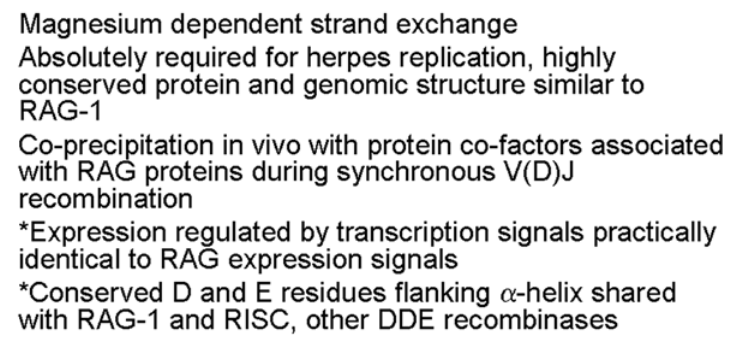
Figure 7. Summary of functional correlates between RAG-1 and herpes DBP (asterix indicates observations novel to this work, other observations presented previously). These functional correlates are consistent with a homologous descent of both proteins from a common precursor recombinase although analogous convergence of functional properties cannot be excluded.